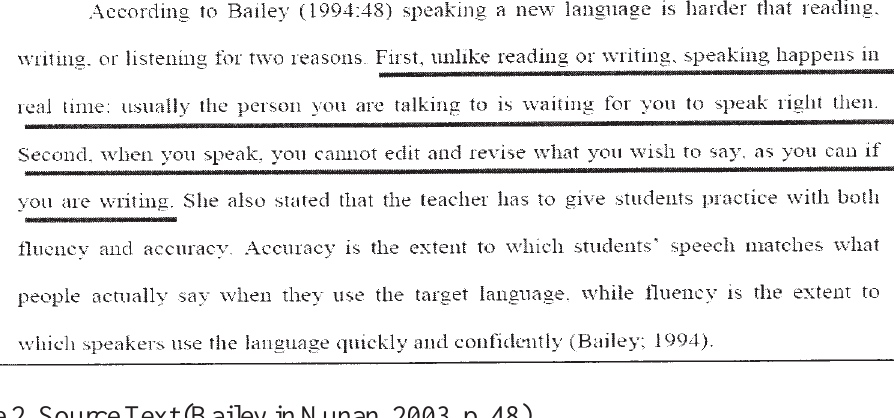
Figure 2. Source Text (Bailey in Nunan, 2003, p.